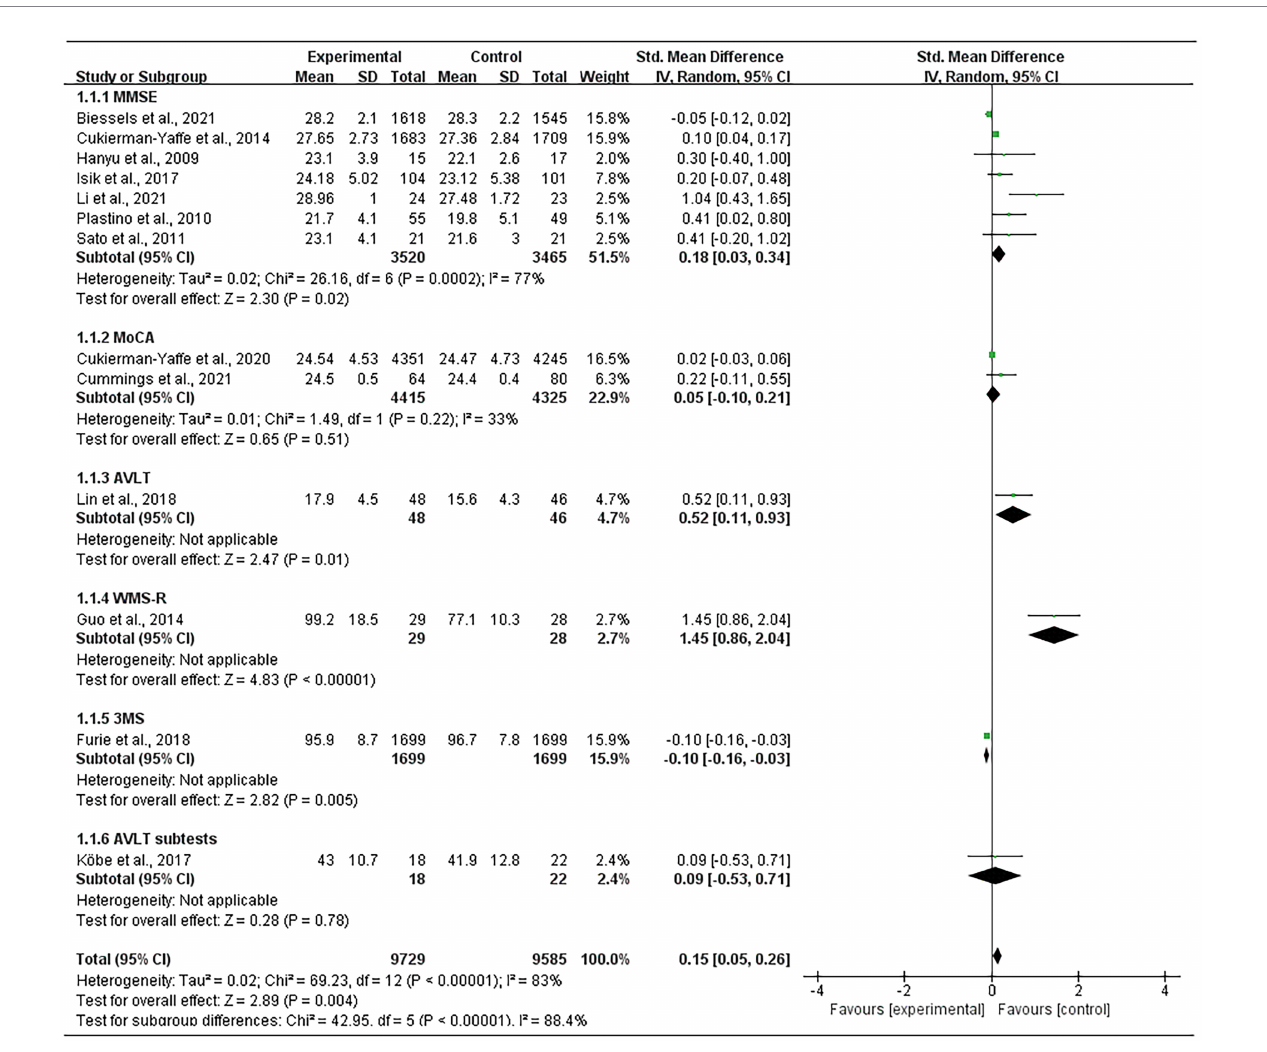
FIGURE 3 Forest plot of unadjusted standard mean difference in cognitive assessment